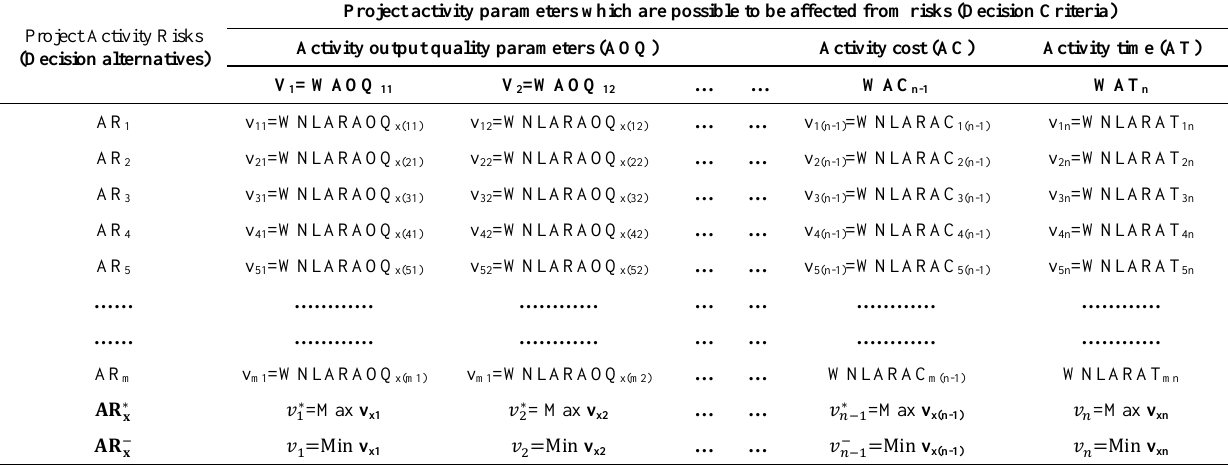
Table 3. Notation transformation table to simply TOPSIS model.